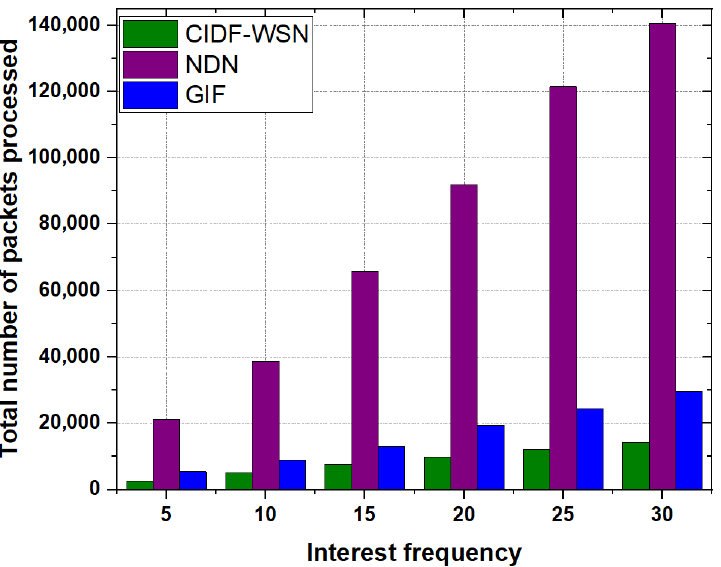
Figure 9. Total Packets processed as a function of Interest